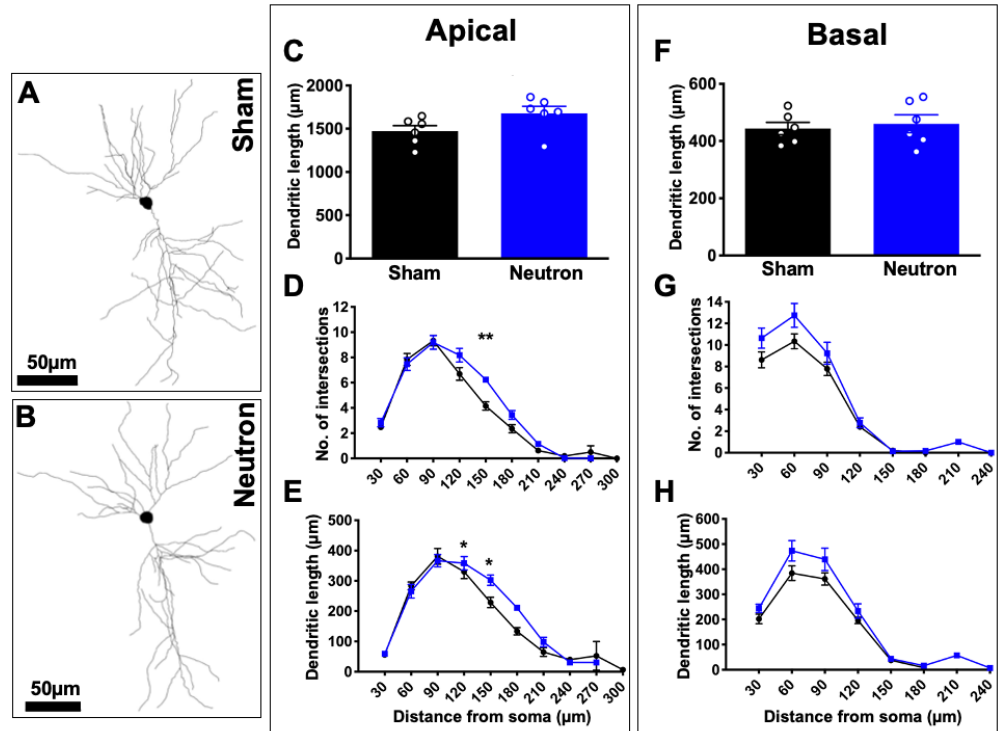
Figure 3. Apical neuronal complexity altered in response to chronic low-dose irradiation. Representative cell tracings from sham ( A ) and neutron ( B ) exposed mice. Scale bar = 50 mm. ( C ) Analysis of apical dendritic length. ( D , E ) Sholl analyses of apical dendrites. ( F ) Analysis of basal dendritic length. ( G , H ) Sholl analyses of basal dendrites. * p < 0.05; ** p < 0.01. Data represents mean ± SEM.